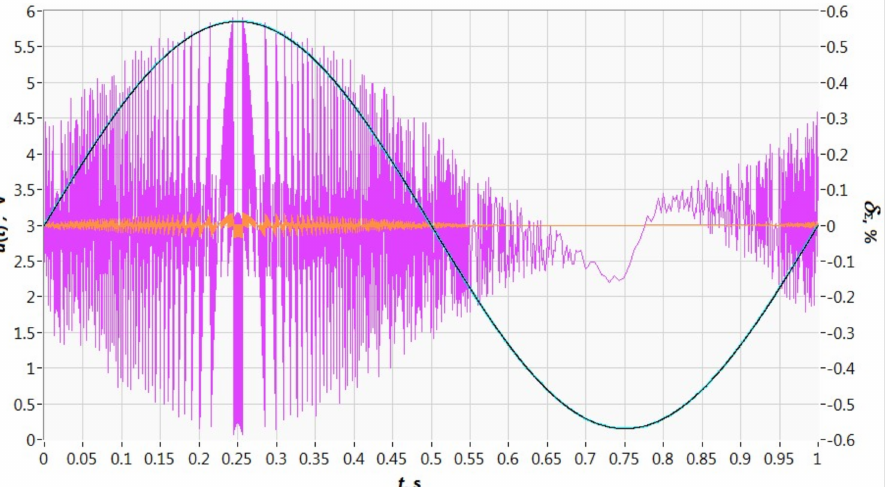
Figure 17. The results of the simulation of sinusoidal test wave processing by the f/N converter while forcing the period of the clock signal 2 T 0 .